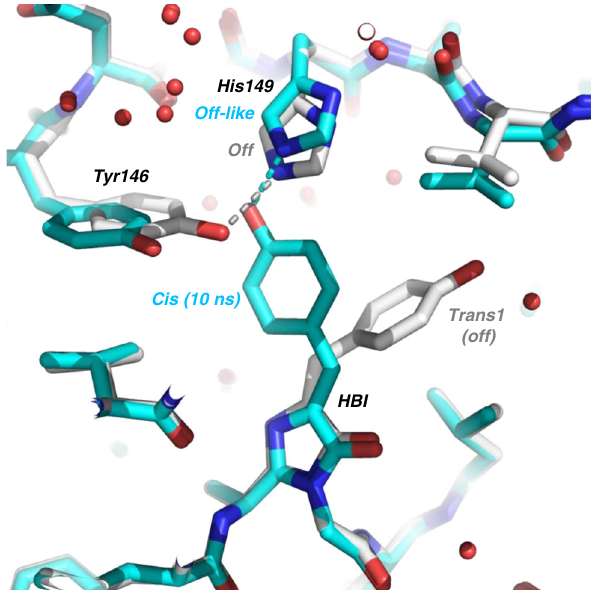
Fig. 5 Overlay of 10-ns intermediate-state and off-state structures. The chromophore regions in the 10-ns intermediate structure (cyan) and the laser-off model (gray) are shown. For the sake of clarity, only the major conformer (65% occupancy) of the laser-off model is shown. Note that His149 is hydrogen bonded to Tyr146 in the laser-off model and to the chromophore in the 10-ns intermediate structure.